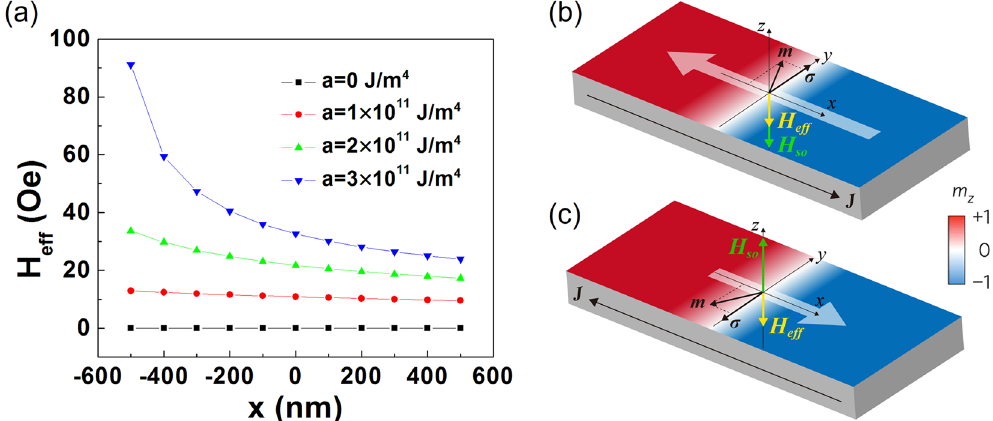
Figure 7. ( a ) The effective field due to the magnetic anisotropy gradient and its variation with x . The slopes for K ( x ) function of ( a ) are 0 (marked in black), 1 × 10 11 (marked in red), 2 × 10 11 (marked in green), and 3 × 10 11 J/ m 4 (marked in blue). ( b ) and ( c ). Schematic of DW motion driven by both effective fields contributed from SOT ( H SO ) and the gradient of magnetic anisotropy ( H eff ). When current is along ( b ) + x direction, both H SO and H eff are in the − z direction, while when current is along ( c ) − x direction, H SO and H eff have opposite